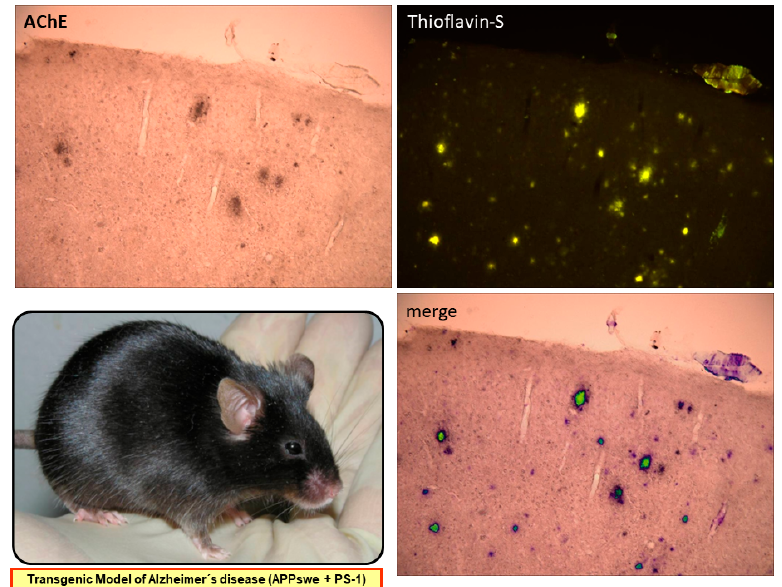
Figure 2. AChE interacts with A β in amyloid plaques. Thioflavin-S is used to stain amyloid plaques. Merging the detection of amyloid plaques and of AChE activity confirms colocalization in the brain of an APP/PS1 mouse model of AD (AChE: acetylcholinesterase; APP: amyloid precursor protein; PS1: presenilin 1).